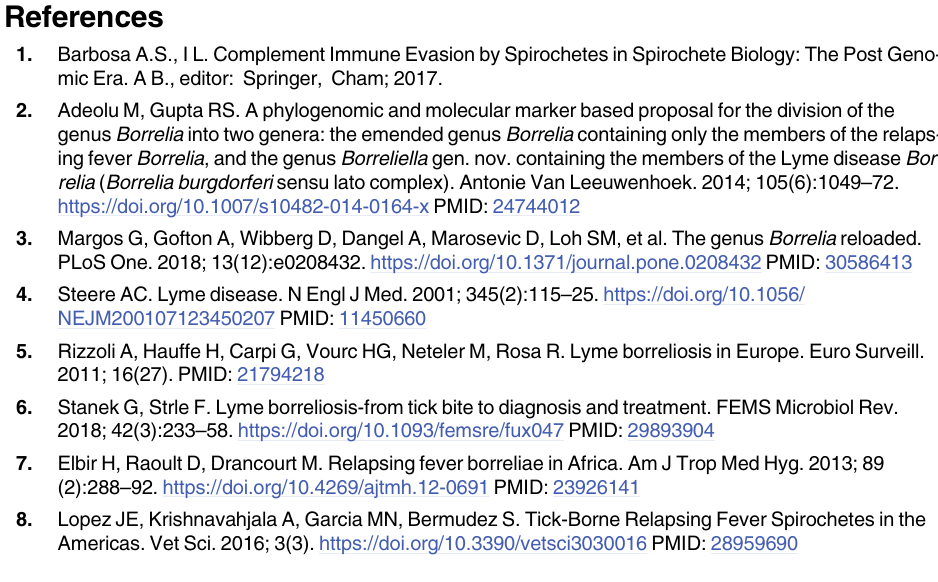
S3 Table. Analysed available genomes for FhbA-related, CspA/CRASP-1, CspZ/CRASP-2 and OspE genes in Borrelia